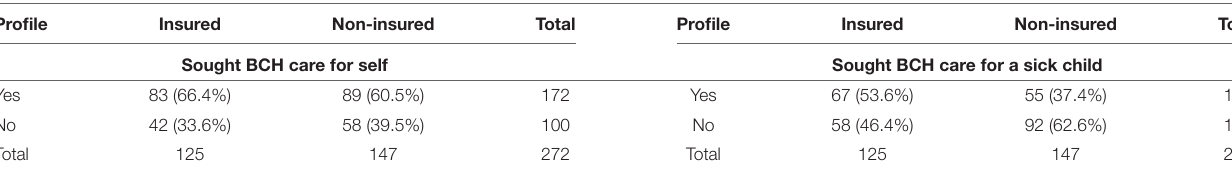
TABLE 3 | Respondents that recall utilizing BCH services.